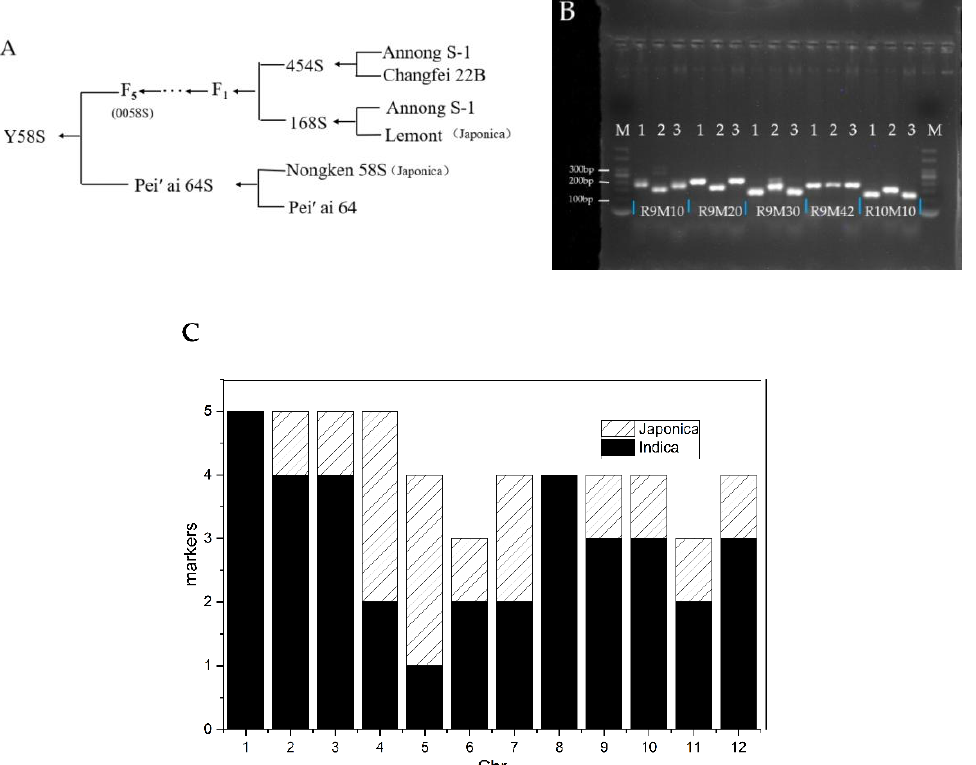
Figure 10. Pedigree and japonica background of Y58S. ( A ) Y58S pedigree; ( B ) Y58S background results of japonica rice detection. M: Marker; 1: 9311; 2: Nipponbare; 3: Y58S; R9M10R9M20R9M30, R9M42, R10M10: molecular detection markers; 100 bp, 200 bp, 300 bp: fragment size. ( C ) Distribution of Indica-japonica genetic background on 12 chromosomes in Y58S.